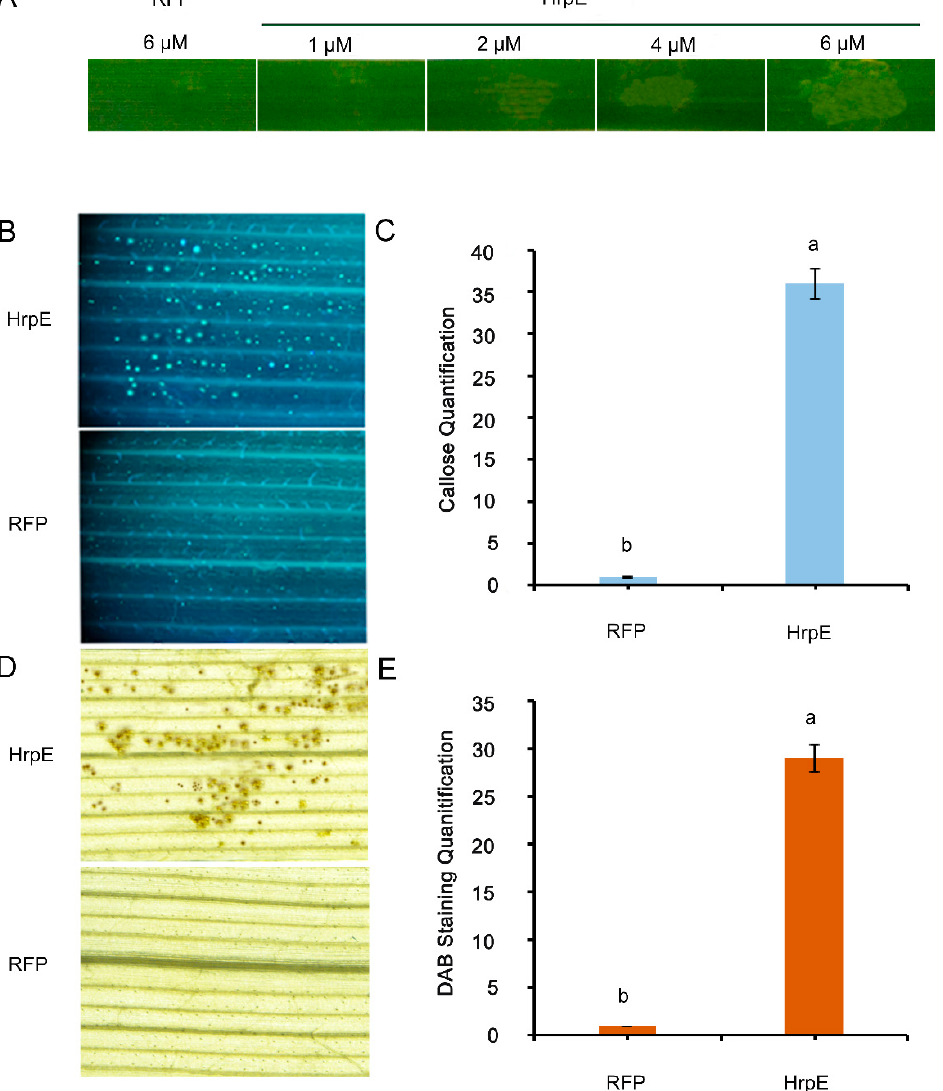
Figure 5. Analysis of rice leaf response to Xoo HrpE. Leaf response to infiltration of purified HrpE at di ff erent concentrations and 6 µ M RFP as a control 24 hpi ( A ). Photographs representing the deposition of callose in rice leaves center-infiltrated with HrpE, with RFP as a control ( B ). Quantification of callose deposition intensity in rice leaves ( C ). Representative photographs for H 2 O 2 accumulation in leaves of rice infiltrated with HrpE, with RFP as a control ( D ). Quantification of H 2 O 2 accumulation in rice leaves by DAB staining in rice leaves ( E ). For callose quantification and DAB staining quantification, values are the mean calculated from 10 di ff erent photographs. Each experiment was repeated three times. Error bars represent standard deviations. Di ff erent letters on the graph bars represent significant di ff erences among the treatments at p < 0.05.